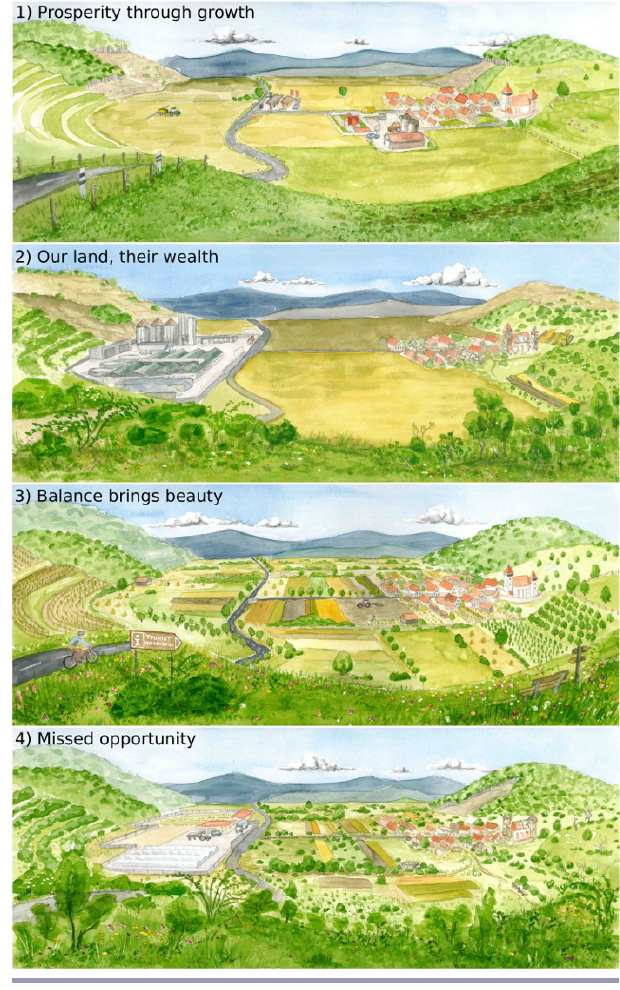
Fig. 6. Scenario matrix highlighting four plausible alternative futures arising from the combinations of two axes describing key uncertainties regarding future development. The horizontal axis relates to exogenous uncertainties, namely, whether national and supra-national policies emphasize economic development or environmental sustainability. The vertical axis relates to uncertainties within the study area, namely, whether local communities are able to capitalize on social and economic opportunities that may arise in the future.